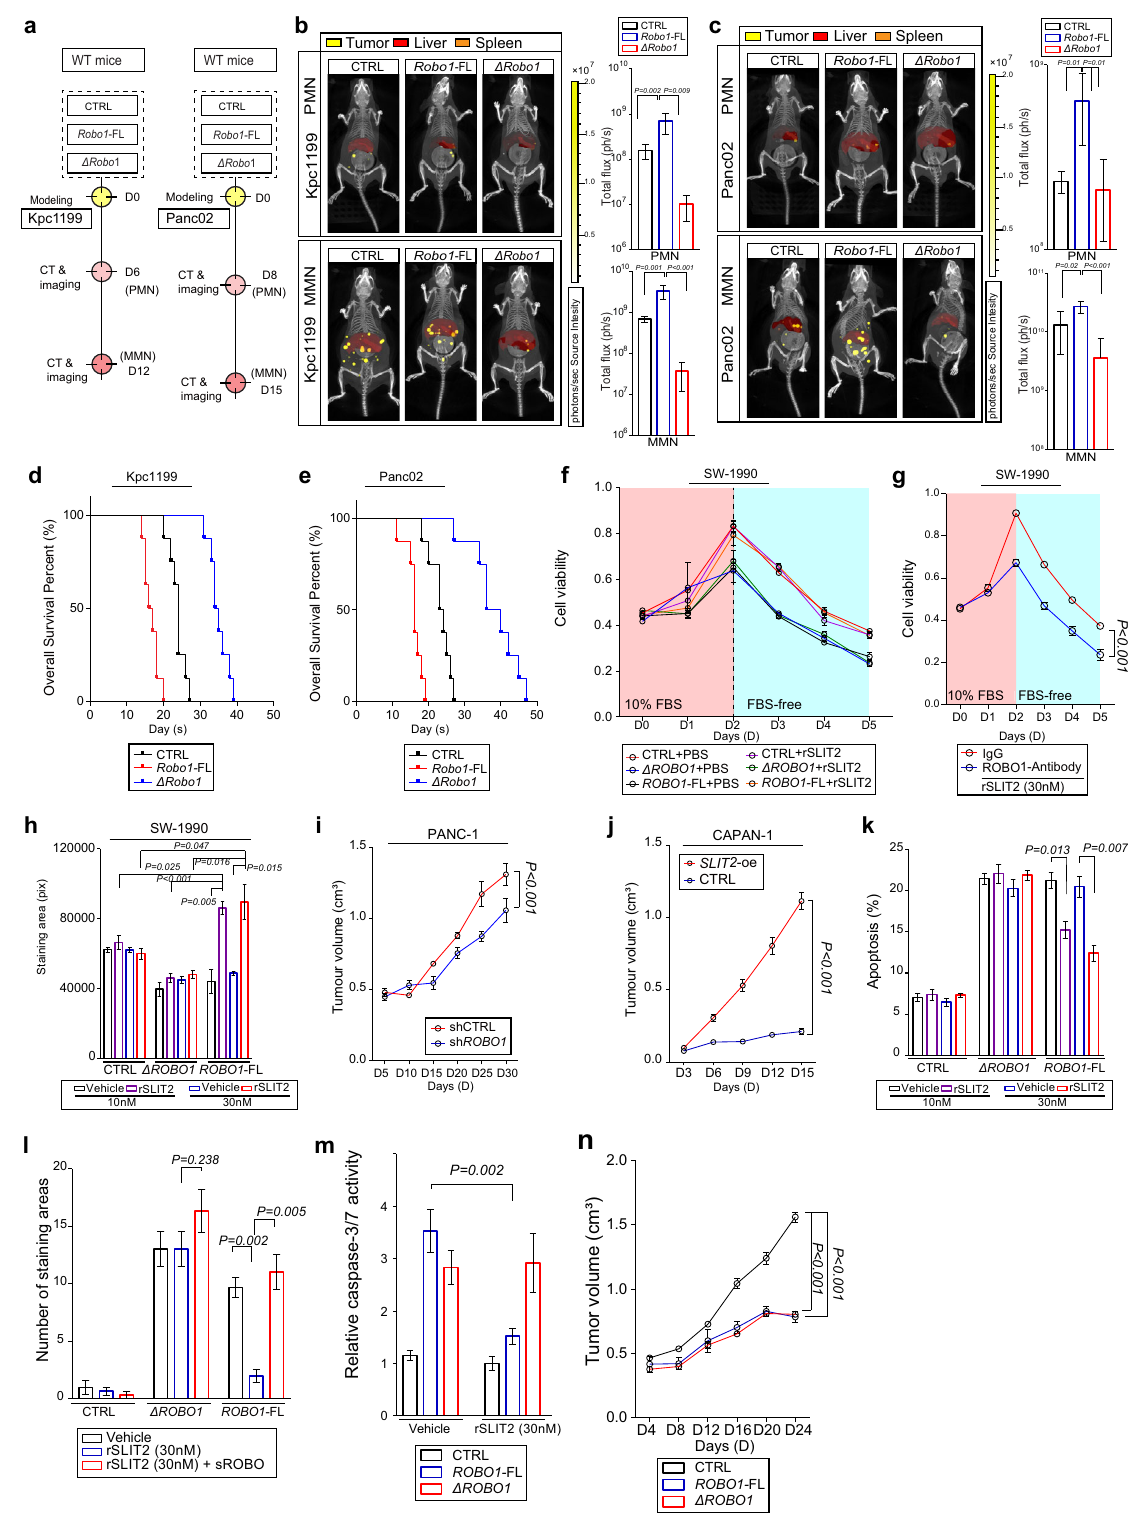
a transgenic PDAC mouse model. Slit2 fl / fl mice and Alb1 -Cre mice were purchased from Cyagen. All the above mice were on the C57BL/6 genetic background. All C57BL/6 wild-type mice and nu/nu mice were purchased from East China Normal